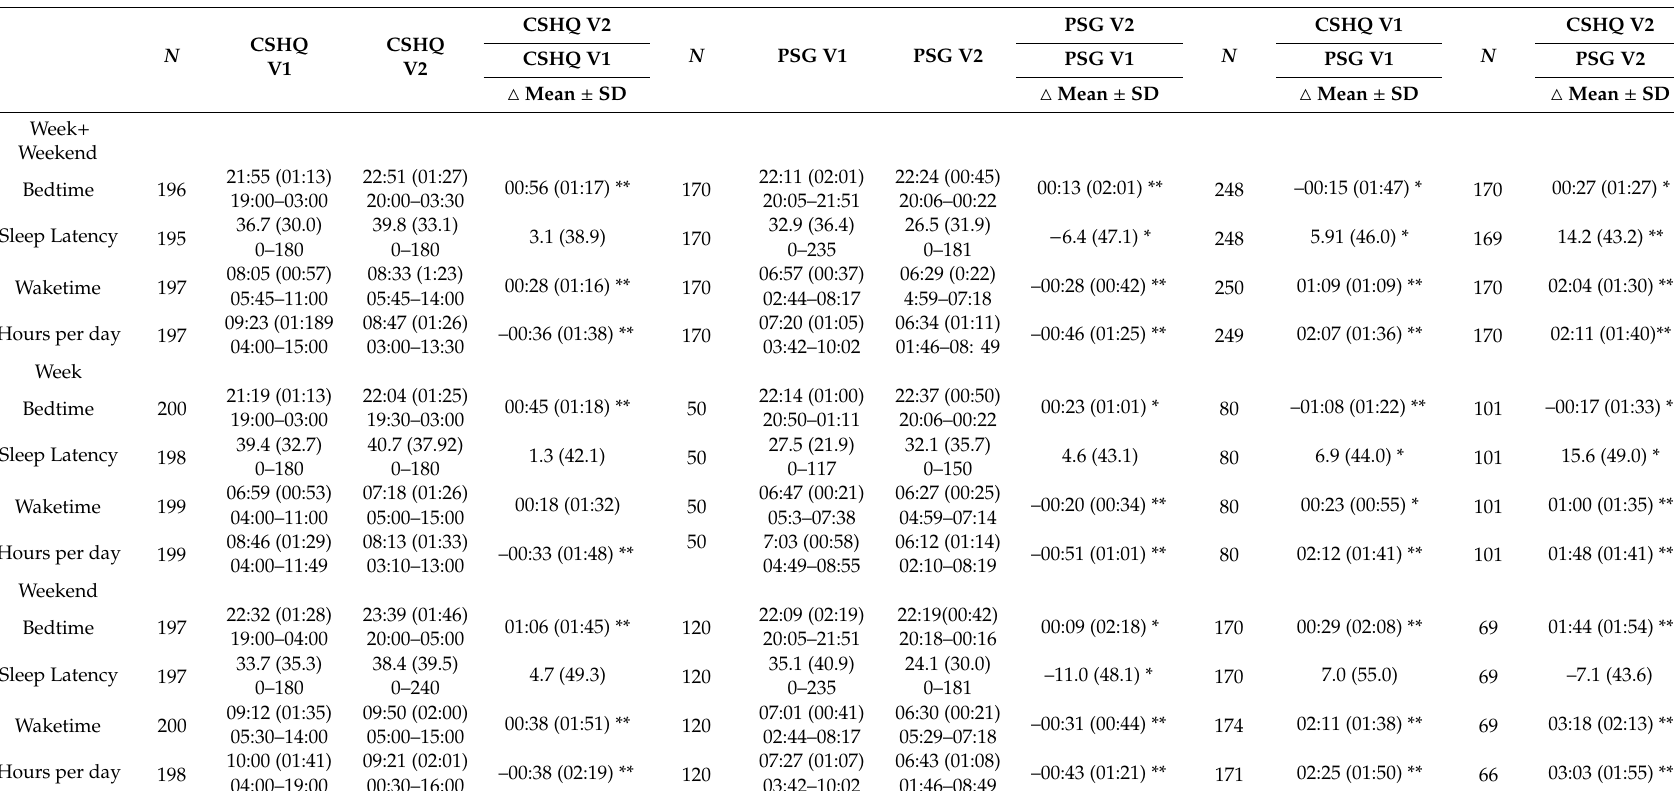
Table 2. Mean ± SD, range and (cid:52) Mean ± SD for Child Sleep Habit Questionnaire and Polysomnography for study 1 and